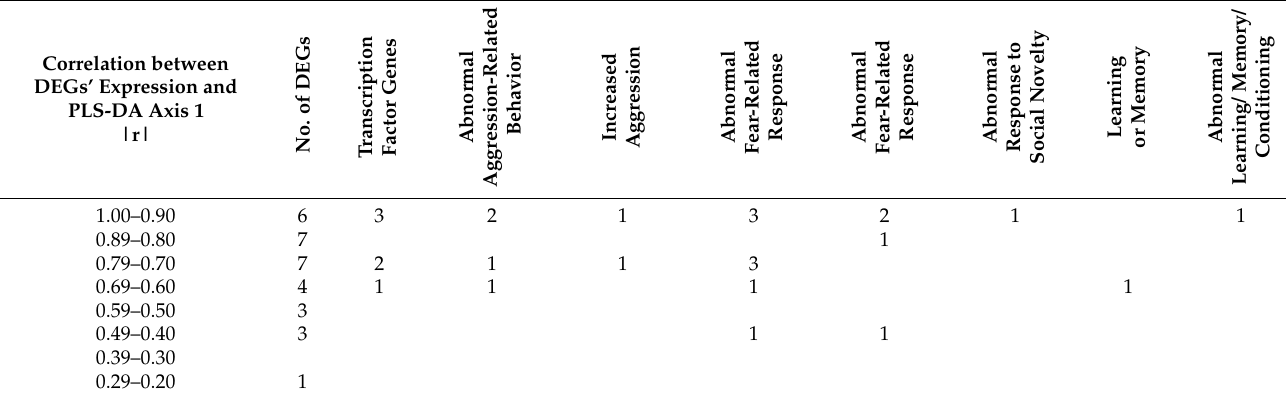
Table 4. Characterization of C_AD DEGs associated with neurogenesis.